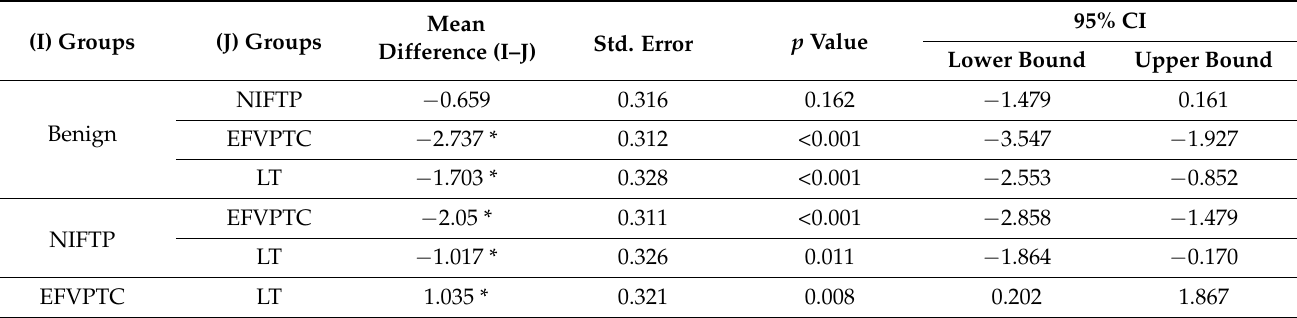
Table 3. Comparison of cytoplasmic Gal-3 expression among groups of Benign, NIFTP, EFVPTC and Lymphocytic thyroiditis (LT).